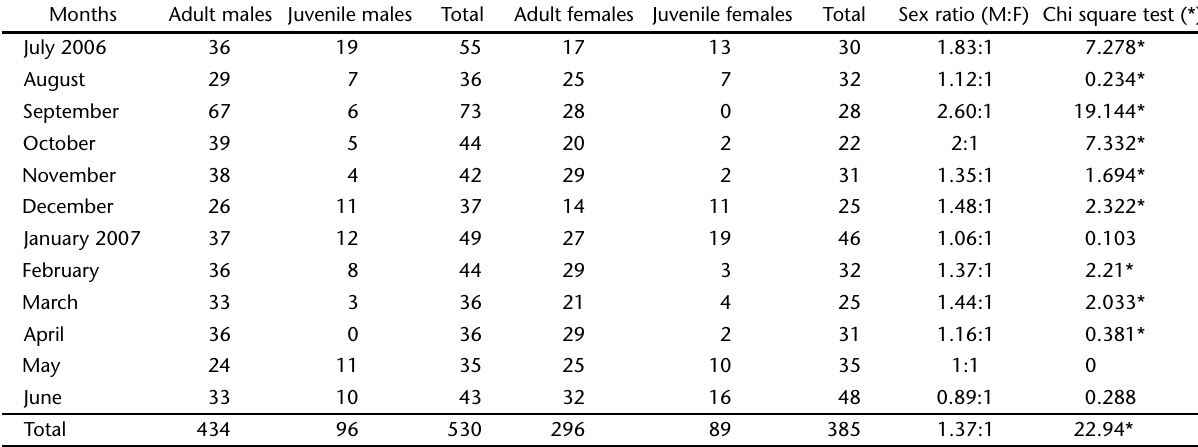
Table I. Number of adult males and females, number of juveniles, sex ratio and population density by month of U. rapax from Itaipu Lagoon. (*) Significant deviations of the 1:1 proportion to sex ratio (p <